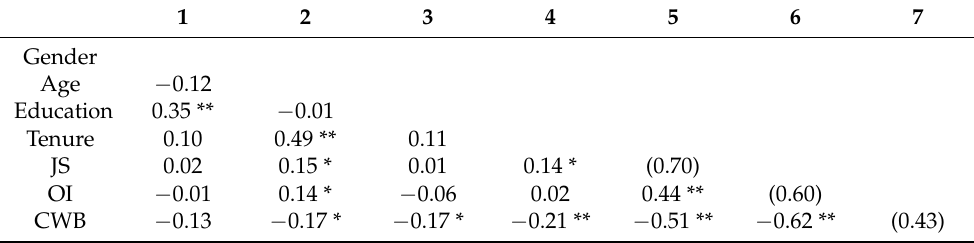
Table 2. Correlations among the study